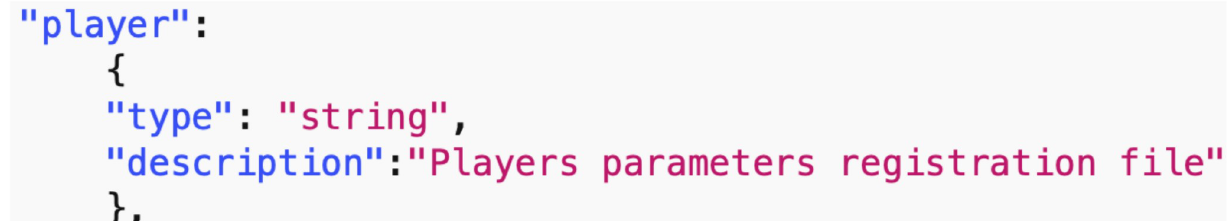
Fig 28. To run a pipeline (called a job), a configuration input file specifies functions and their order of execution. This Figure shows a portion of the schema for a configuration file that specifies the player description JSON schema file location.